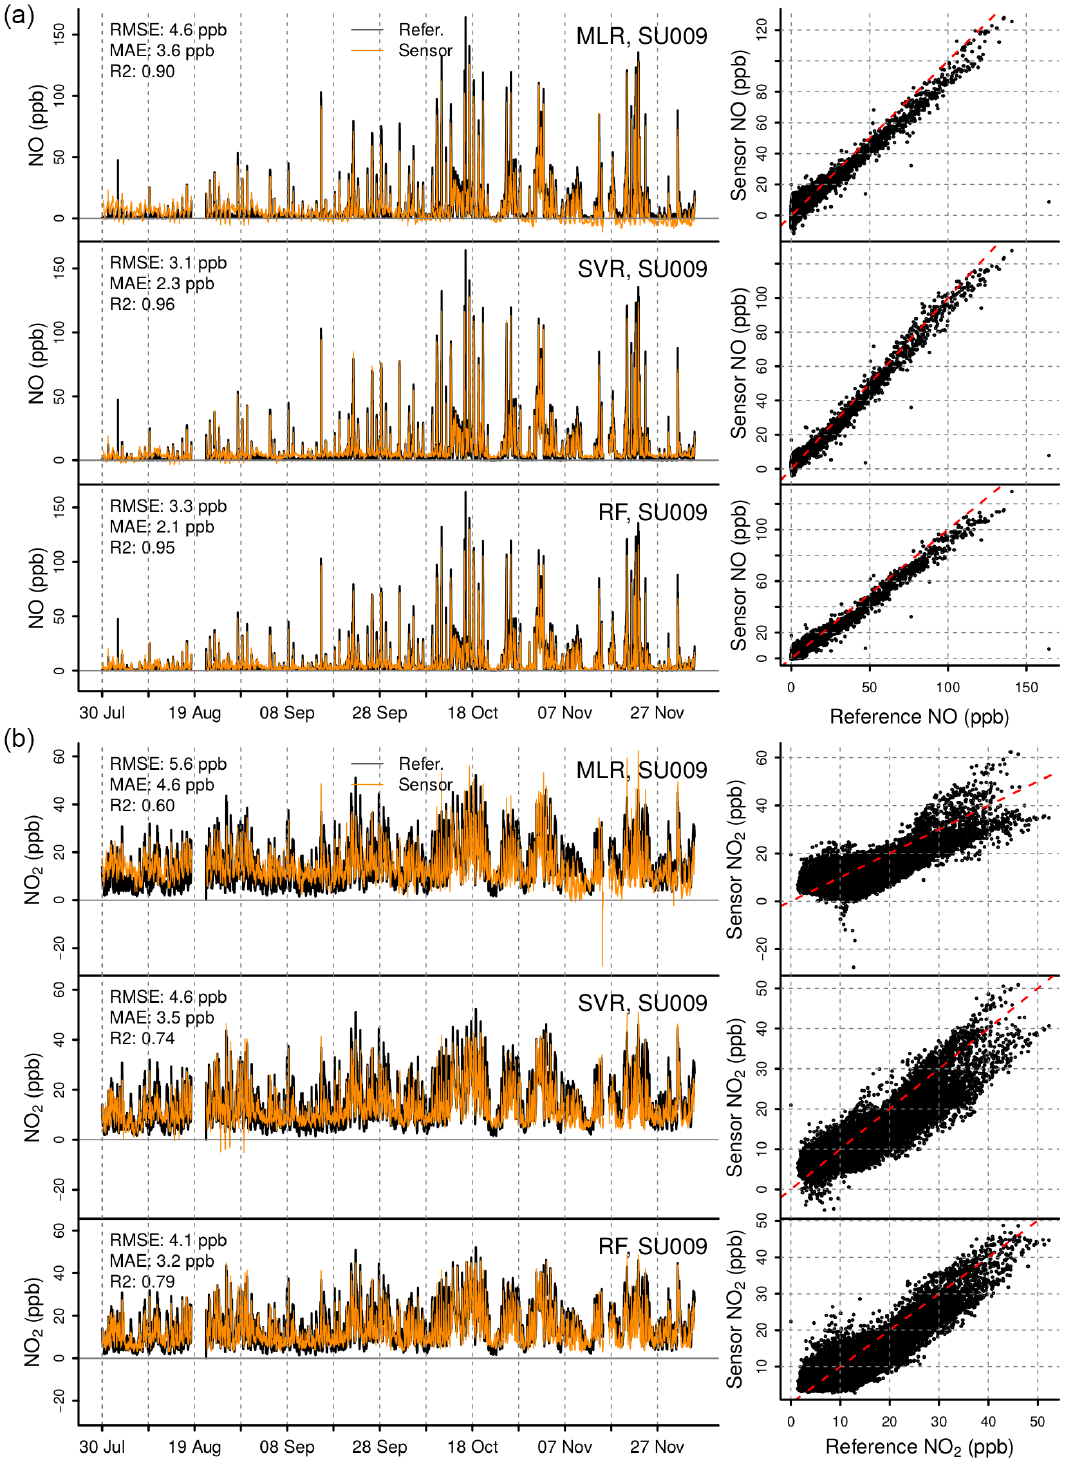
Figure 4. Comparison of NO (a) and NO 2 (b) estimates by SU009 with observations by reference instruments, at the urban background site Zurich-Kaserne. 1 : 1 red dashed line is added in the